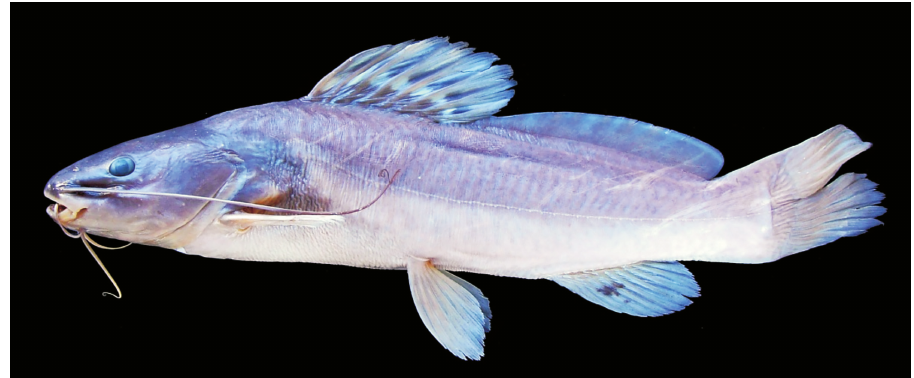
Fig. 6. Lateral view of Rhamdia voulezi , LISDEBE 5529, 214.0 mm SL, Brazil, Paraná, São José dos Pinhais, rio Iguaçu, marginal pound and lagoons at Torres Avenue, sides of Reserva do Cambuí.